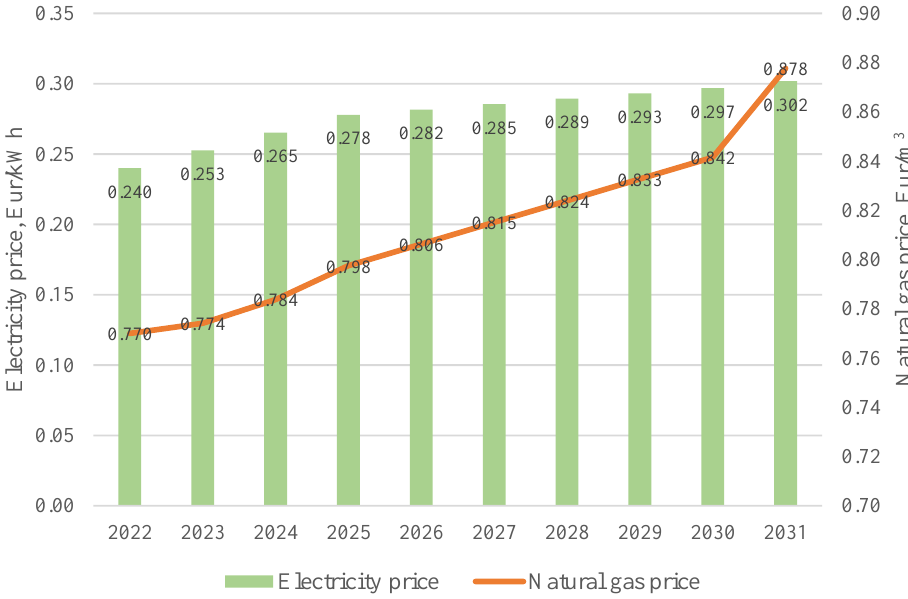
Figure 6. Forecasted trend of natural gas and electricity prices in Lithuania for the period of 2022–2031.